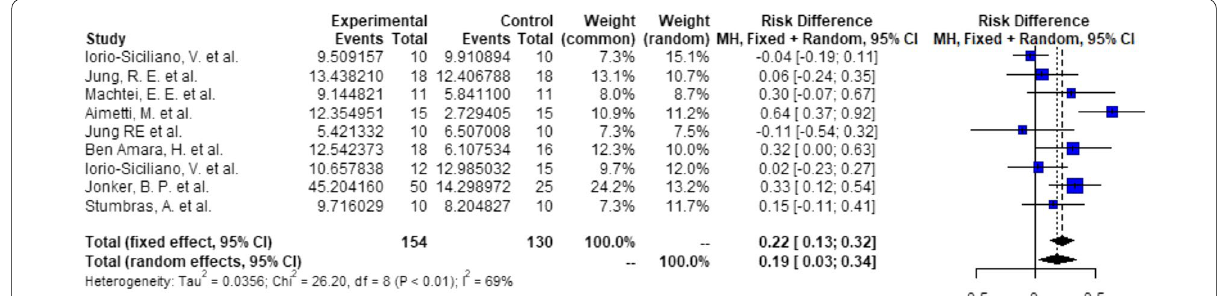
Fig. 4 Meta-analysis results for the binary outcomes for implant placement in a bone envelope of 5.25 mm